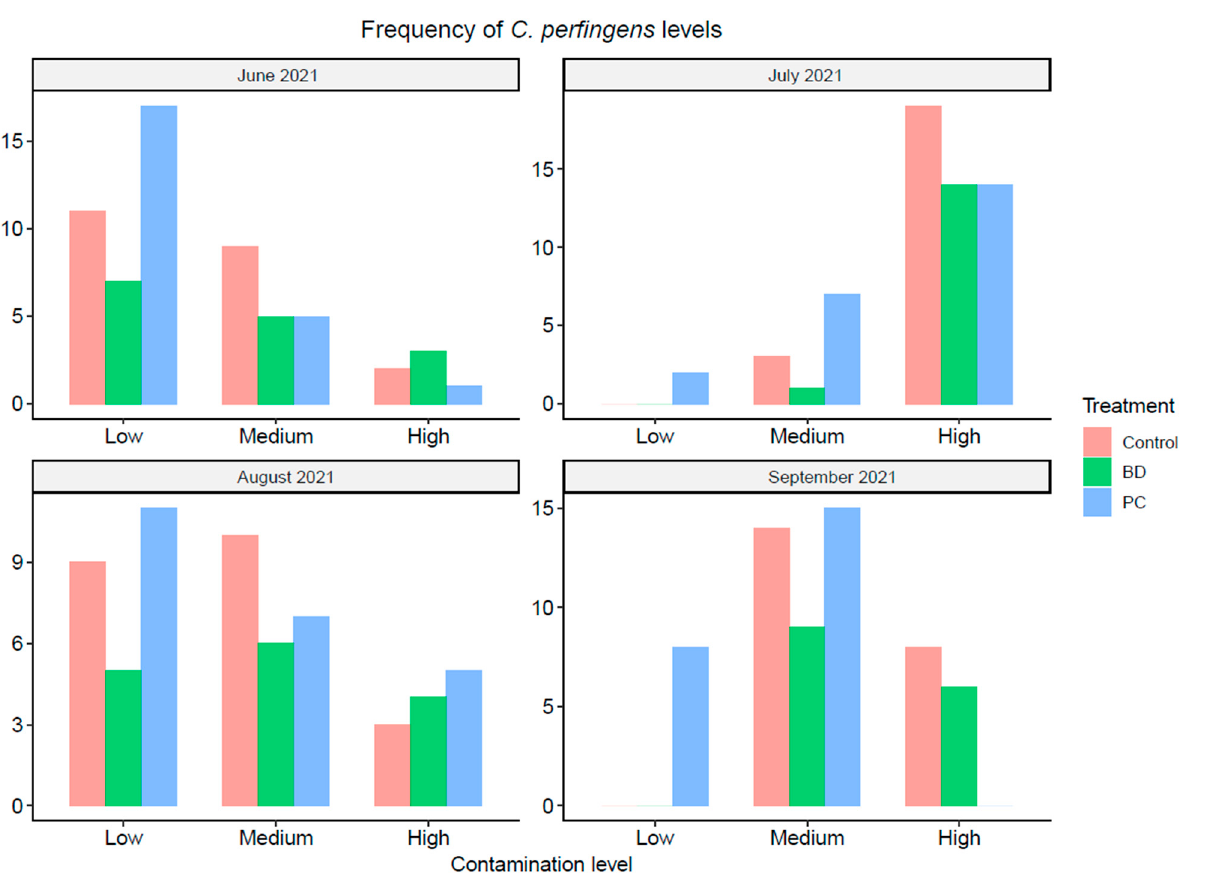
Figure 4. Frequency (number of samples) of C. perfringens contamination levels in fecal samples collected from the pen floors over a 4-month period sampling three different treatment groups. The contamination level is represented on a scale of low, medium, and high. High being > 4 log 10 CFU/g, medium being > 2 log 10 CFU/g, and low being ≤ 2 log 10 CFU/g. Each bar represents the number of samples for that treatment that fall into each contamination level category for each of the four distinct sampling dates.